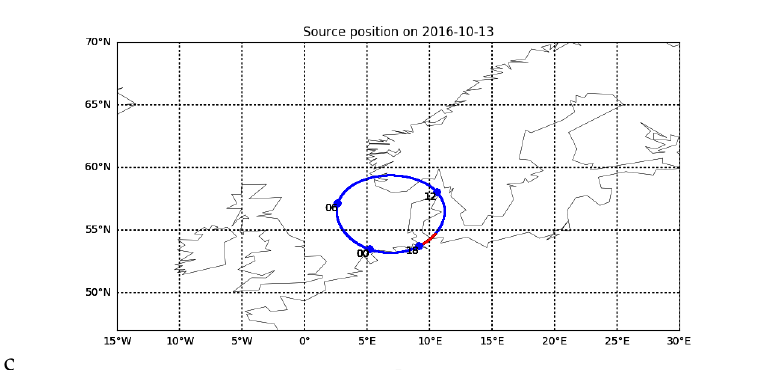
Figure 7. Daily positions of IPPs: ( a )—L547449 set; ( b )— L547785 set; ( c )—L552177 set. The red line segment gives IPPs for observation intervals.